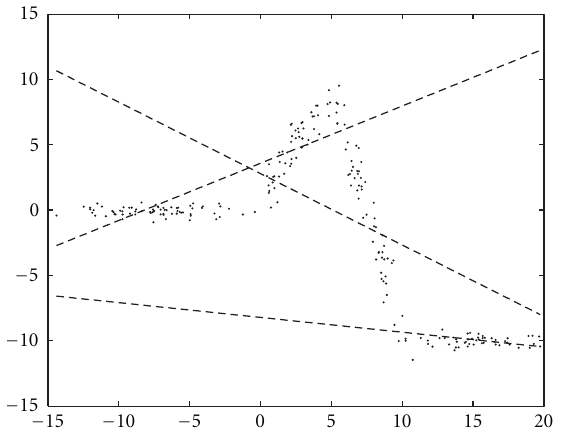
Figure 7: Final hyperplanes (dashed lines) estimated by the hyper- plane clustering in the case M = 3.